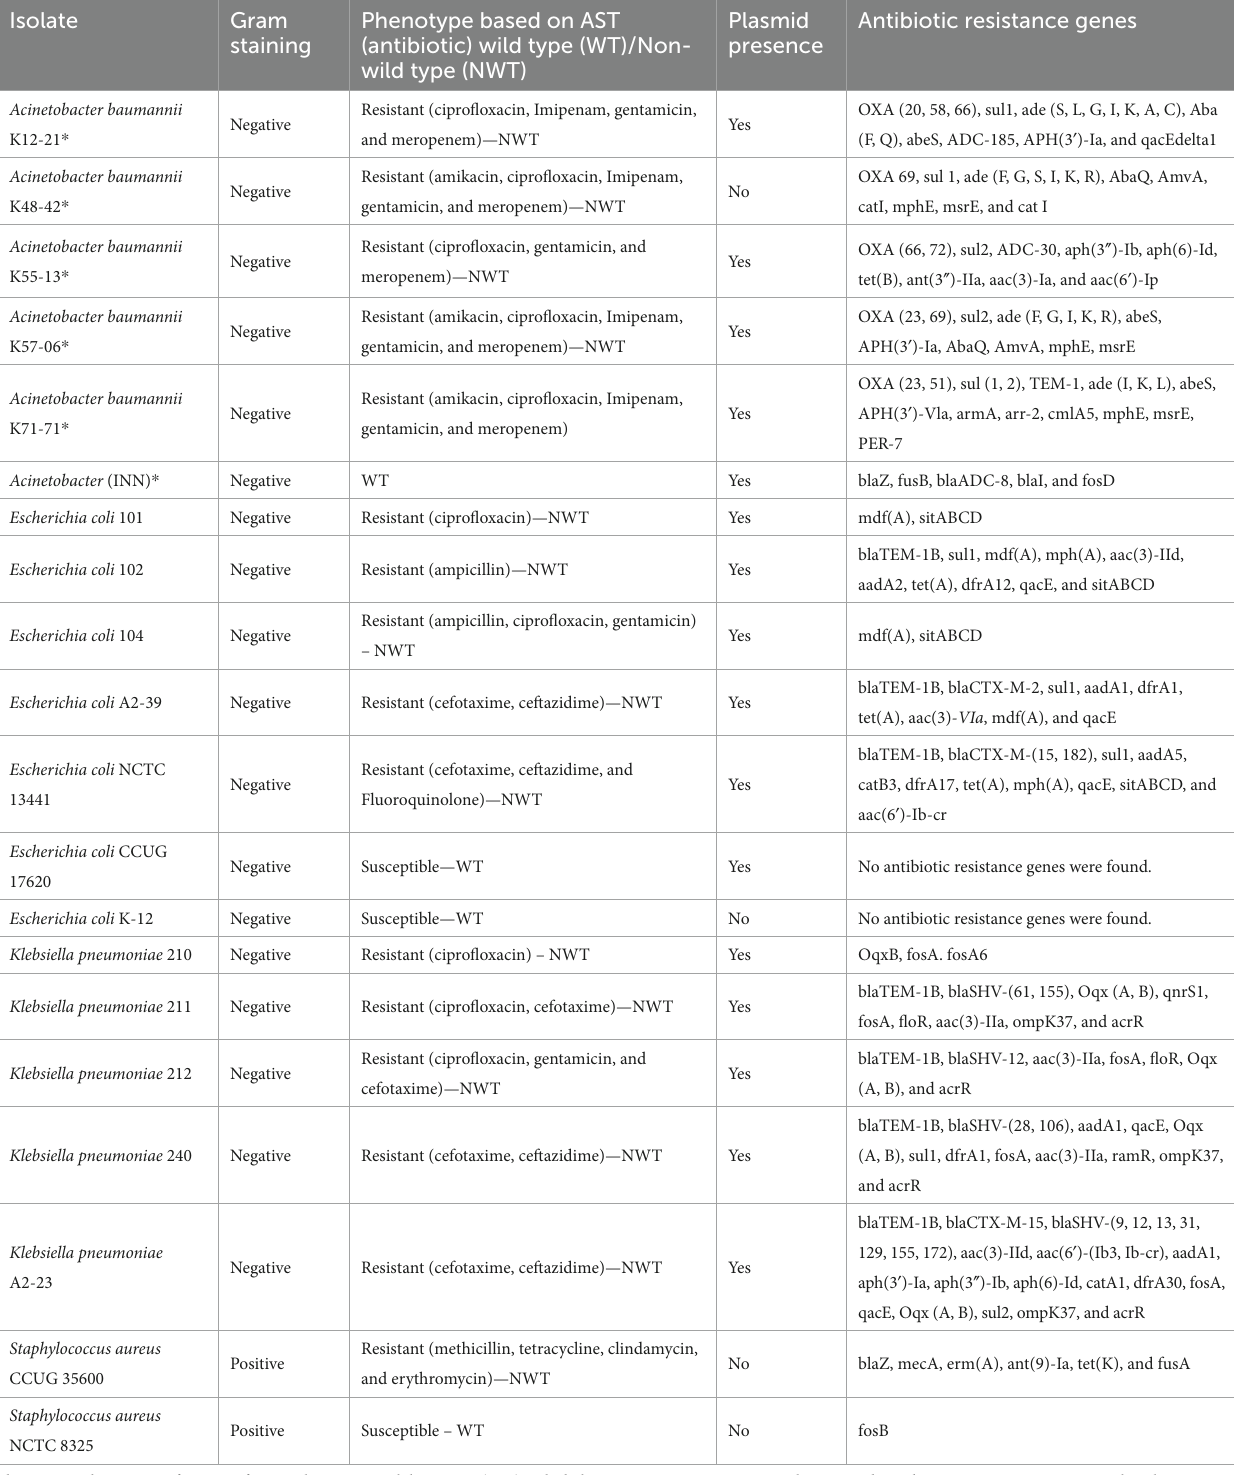
TABLE 1 Overview of bacterial strains’ phenotype and genomic background. Isolate Gram Phenotype based on AST staining (antibiotic) wild type